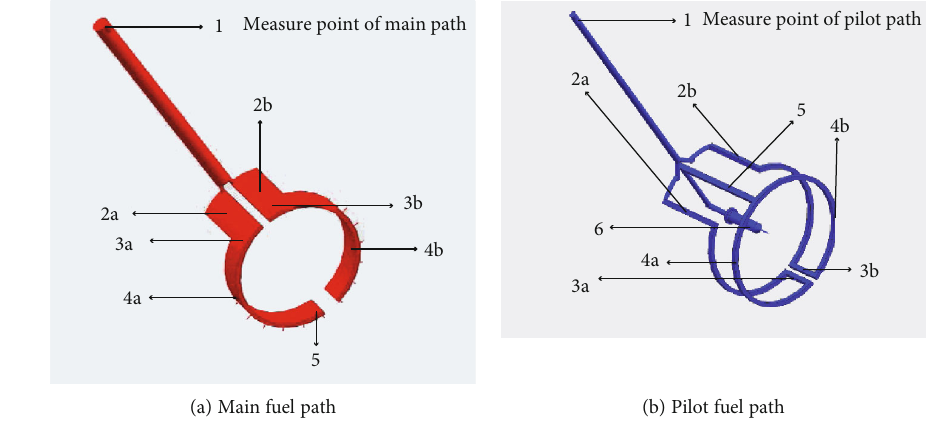
Figure 9: Schematic diagram of the measure point.